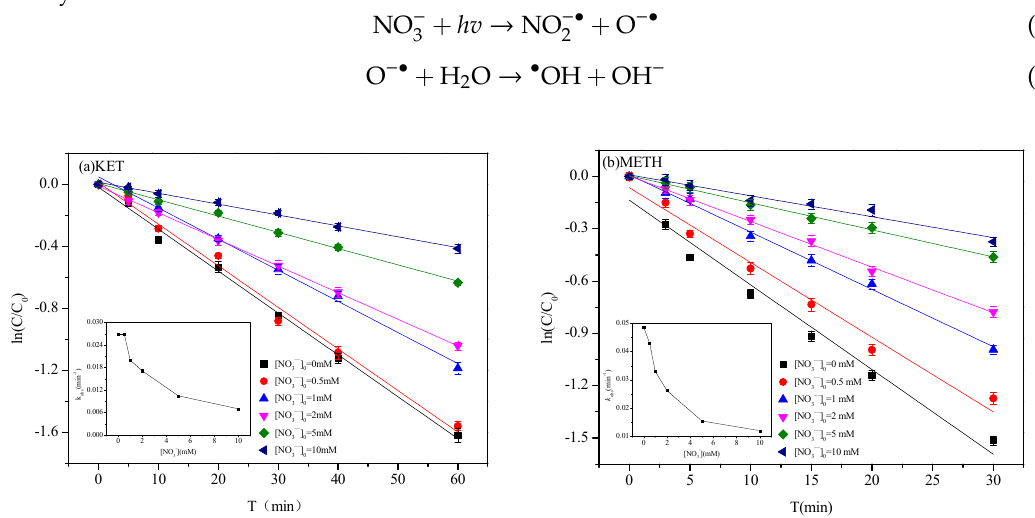
Figure 9. E ff ect of NO 3 − on KET ( a ) and METH ( b ) degradation in the UV / H 2 O 2 system. Conditions: Figure 9. Effect of NO 3− on KET ( a ) and METH ( b ) degradation in the UV/H 2 O 2 system. Conditions: (KET) 0 = (METH) 0 = 100 µ g / L, (H 2 O 2 ) 0 = 500 µ M, pH 0 = 7.0, T = 25 ± 1 ◦ (KET) 0 = (METH) 0 = 100 μg/L, (H 2 O 2 ) 0 = 500 μM, pH 0 = 7.0, T = 25 ± 1 °C.